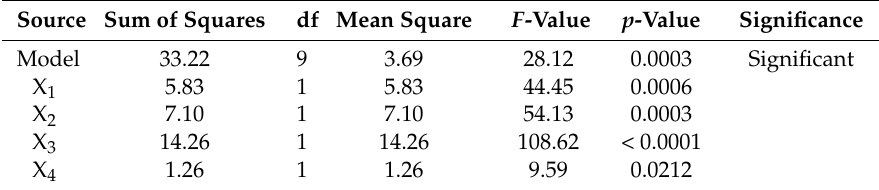
Table 2. ANOVA of the two-level factorial